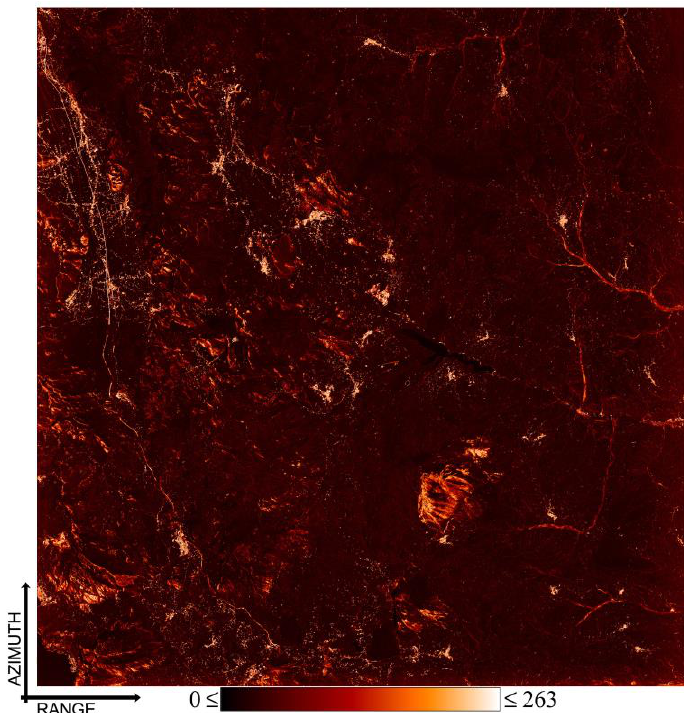
Figure 10. A spatial map of the investigated area in SAR coordinates related to the number of interferograms used for each pixel by the WSVD time-series inversion.